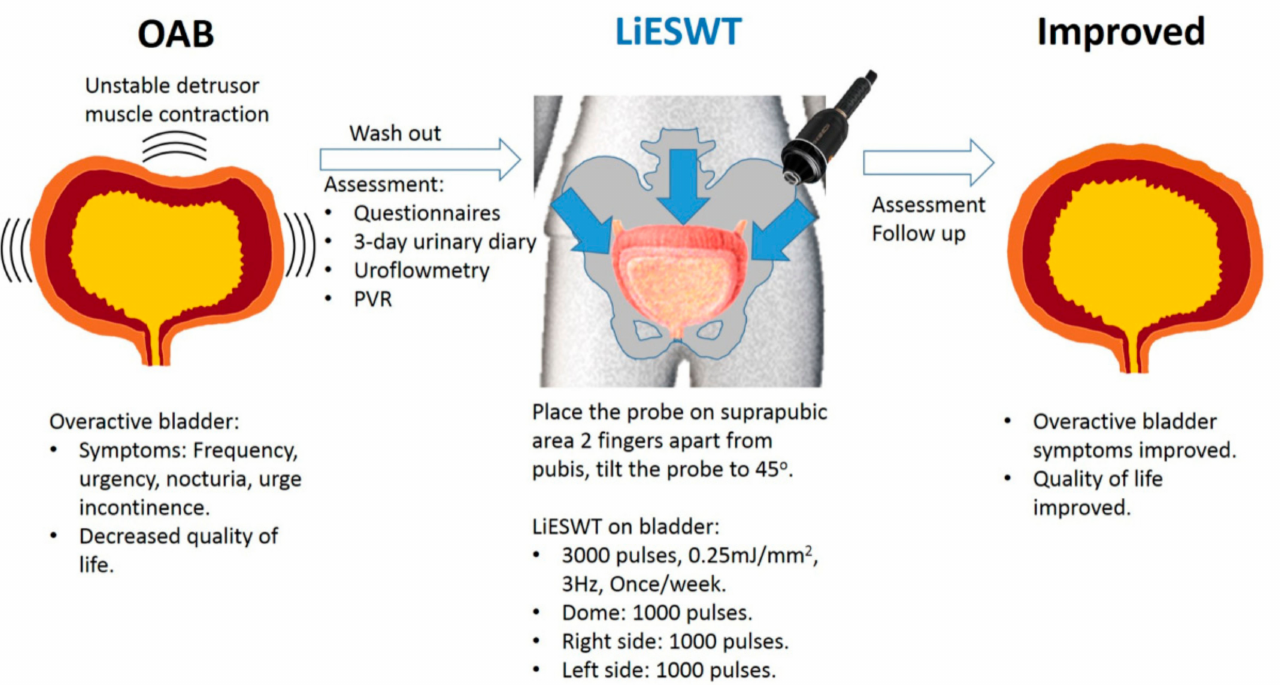
Figure 4. A brief diagram proposed for the potential effects of LiESWT on improving the OAB symptoms. OAB: overactive bladder, LiESWT: low intensity extracorporeal shock wave therapy, PVR: measurement of post-voided residual urine